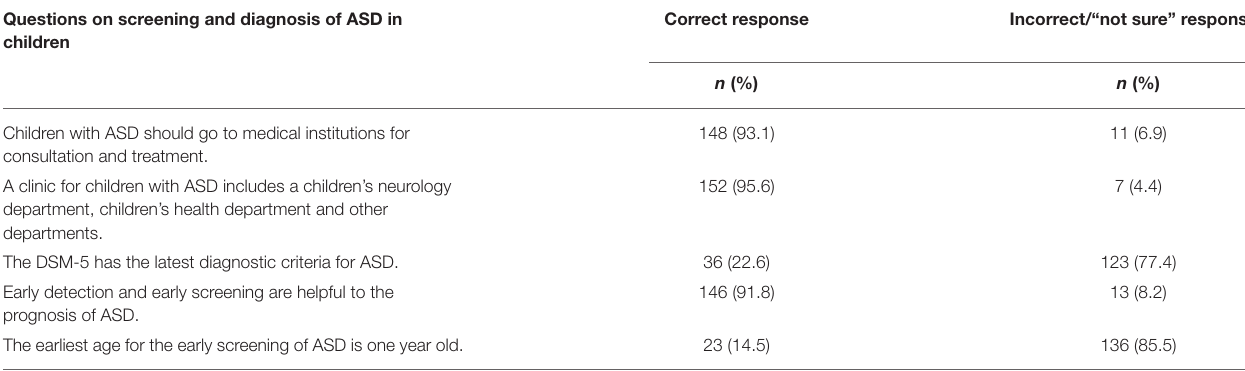
Correct response Incorrect/“not sure” responses